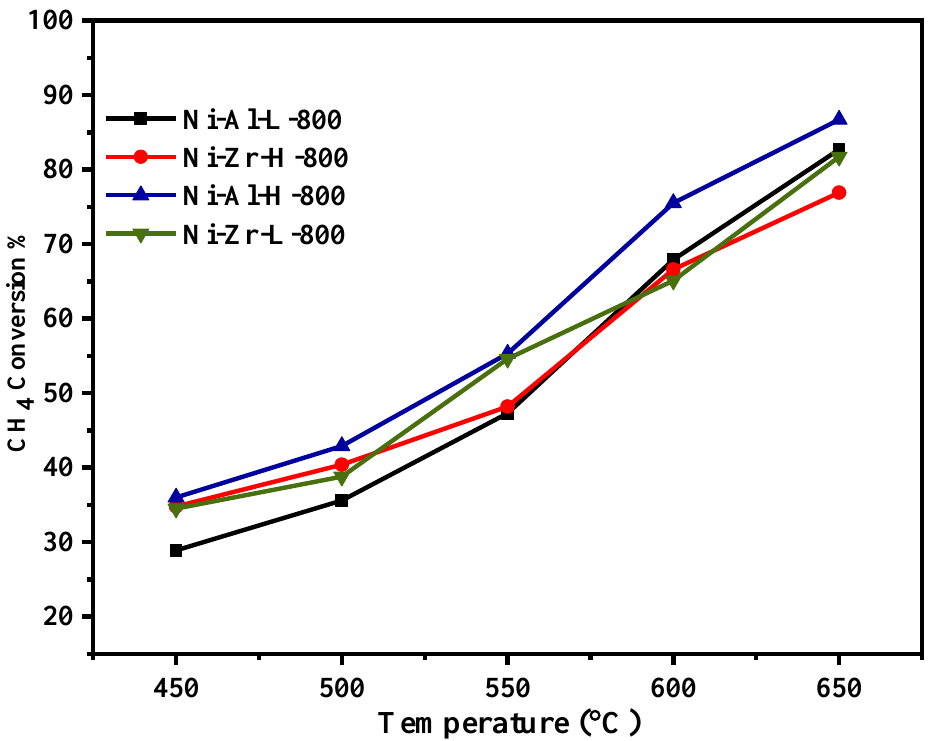
Figure 7. Catalytic activity of catalysts calcined at 800 °C: CH 4 conversion against reaction temperature (450–650 °C).